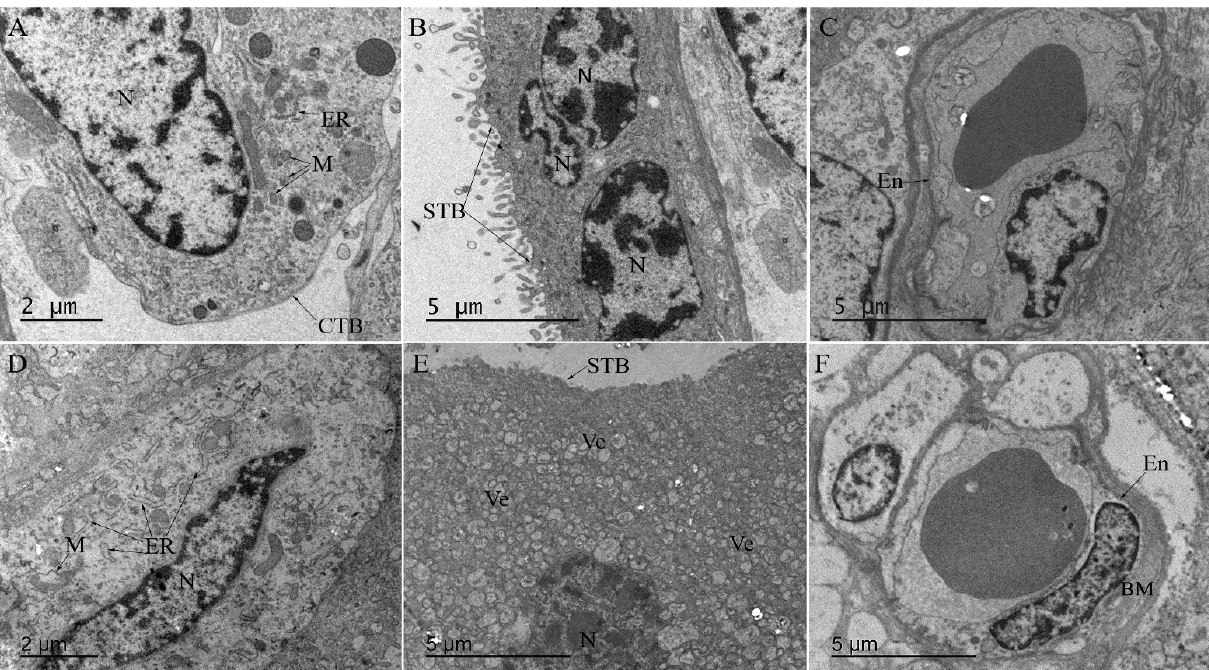
Figure 4. Ultrastructure of CHIKV-infected placenta. ( A ) Electron microscopy of ultrathin sections of non-CHIKV placenta with regular cytotrophoblast organelles (mitochondria and endoplasmic reticulum), ( B ) syncytiotrophoblasts, and ( C ) endothelial cells. ( D ) Mitochondrial swelling with the endoplasmic reticulum exhibiting dilated cisterns in cytotrophoblast, ( E ) vesicles in syncytiotrophoblasts, and ( F ) thickening of the basement membrane of the endothelium. CTB—Cytotrophoblast; STB—syncytiotrophoblasts; ER—endoplasmic reticulum; M—mitochondria; N—nucleus; Ve—vesicles; En—endothelium; BM—basement membrane.